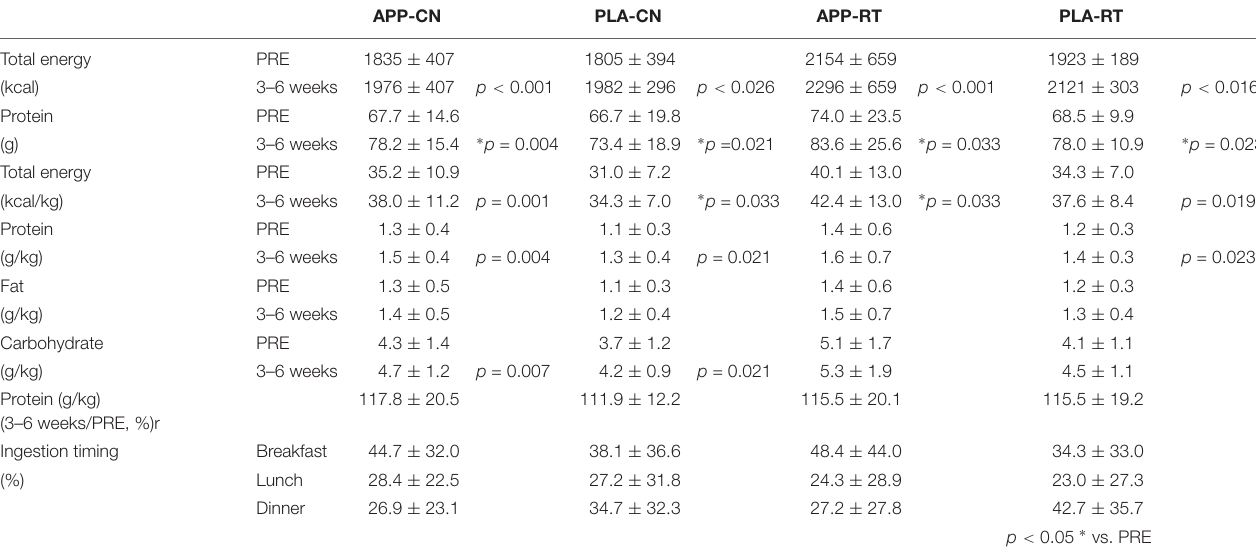
TABLE 2 | Results of diet survey using a food frequently questionnaire (FFQg) and test meal ingestion